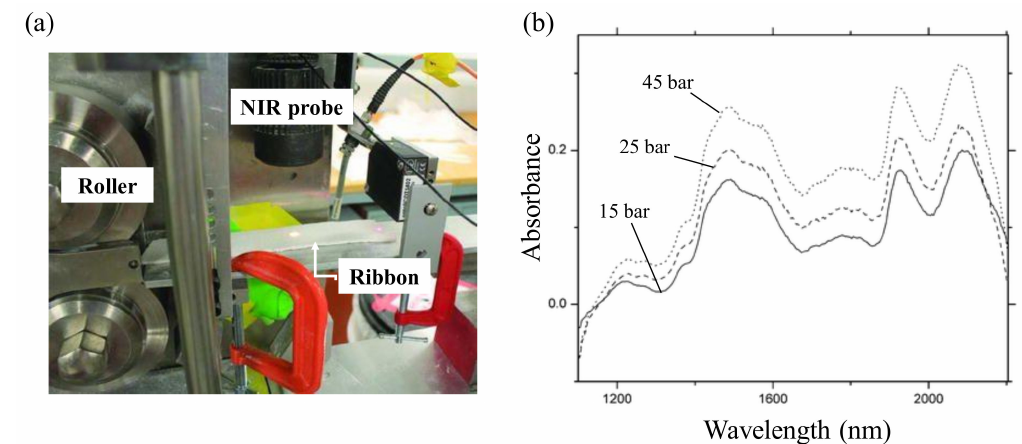
Figure 13. Near infrared (NIR) spectrum measurement of density made at various pressures (15, 25 and 45 bar) [156]: ( a ) in-line setup in roller compactor; ( b ) spectrum obtained at 1100–2205 nm. The figures were slightly modified, with permission from